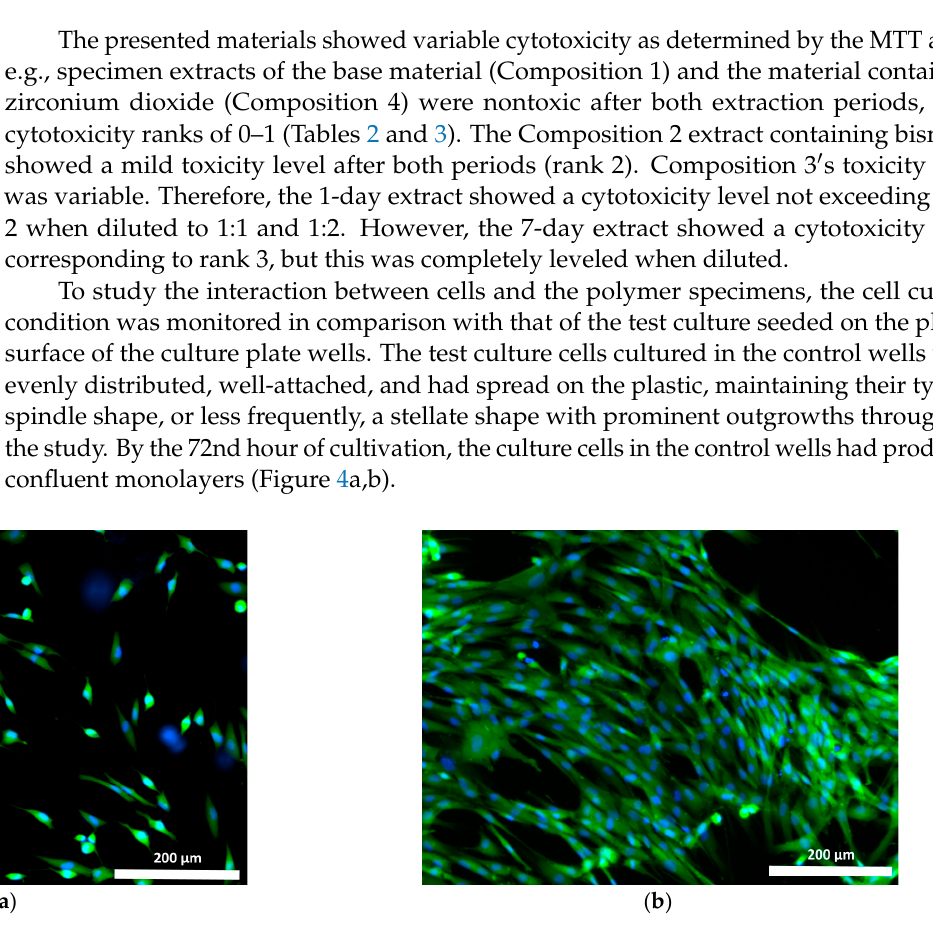
Figure 4. Test culture fibroblasts on plastic (control) (blue stained nuclei—fluorochrome: Hoechst 3334, BD Pharmingen™; green stained cytoplasm of viable cells—Calcein AM fluorochrome, BD Pharmingen™): ( a ) 24 h cultivation; ( b ) 72 h cultivation; mag. 100×.